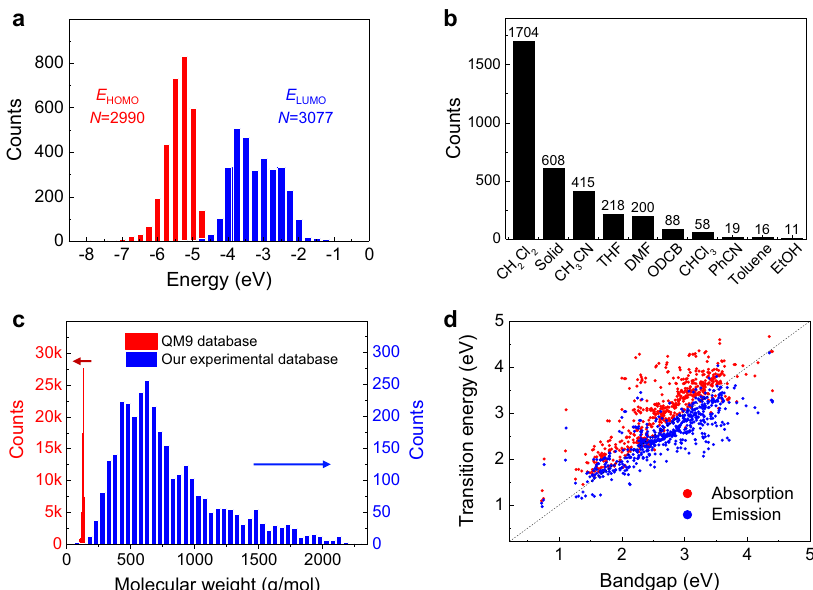
Fig. 1 Experimental database of HOMO and LUMO energies. a Distributions of HOMO and LUMO energies ( E HOMO and E LUMO ) of molecules in our experimental database. The number of datapoints ( N ) is indicated. b Histogram of solvents (CH 2 Cl 2 : dichloromethane, CH 3 CN: acetonitrile, THF: tetrahydrofuran, DMF: N , N -dimethylformamide, ODCB: 1,2-dichlorobenzene, PhCN: benzonitrile, and EtOH: ethanol). c Distributions of the molecular weights of molecules in the QM9 database (in red) and our experimental database (in blue). d Plot of the bandgap ( E g ) vs. the transition energy from our experimental